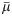
Reproduction accuracy of the reduced models for variations of the mean input.Pearson correlation coefficient (ρ) and root mean square distance (dRMS) between the spike rate time series rN(t) of the aEIF population and r(t) of each derived model (FP, spec1, spec2, LNexp, LNdos) for different strengths of baseline mean input μ¯, input standard deviation σext, mean input variation ϑμ and for a large value of time constant τouμ (A, moderately fast variations) as well as a smaller value (B, rapid variations). The input-output correlation (between μext and rN) is included as a reference (black dashed lines), and mean ± standard deviation of the population spike rate rN are indicated (gray dashed lines, shaded areas). For each parametrization, activity time series of 60 s duration were generated (from 50,000 aEIF neurons and each derived model), from which the first second was omitted (each) to exclude transients, since the initial conditions of the models were not matched. Representative time series examples are shown on the right side with parameter values indicated (C), where empty and filled symbols correspond to large and small correlation time τouμ, respectively, relating the examples to the panels A and B. The adaptation current traces were excluded in all but the first example to allow for a larger number of parameter points.